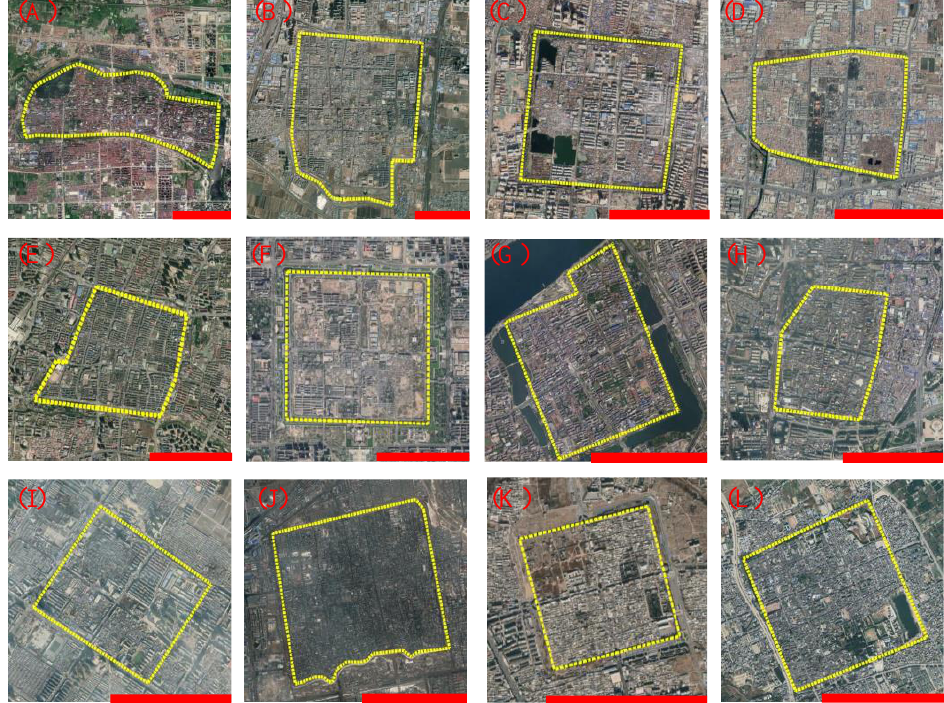
Figure 17. Google remote sensing image of a city in which the walls are still preserved (yellow lines indicate the extent of the wall. Letters ( A – L ) denote Jingzhou, Zhengding, Heze, Qufu, Baoding, Datong, Xiangyang, Nanyang, Fenyang, Pingyao, Xingcheng, and Dali, respectively. Scale bar = 1